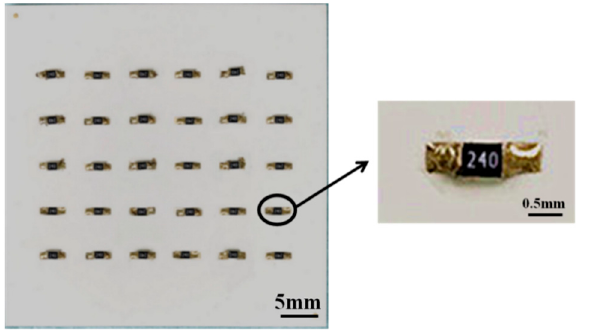
Figure 3. Top view of the micro-joints on Al 2 O 3 substrate.